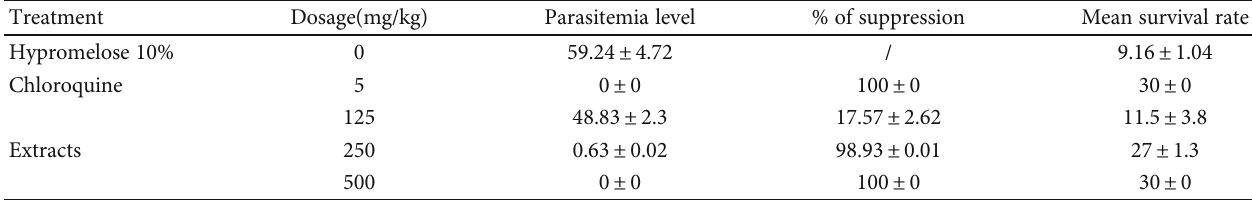
Table 1: Suppressive e ff ect, Parasitemia level and Mean survival